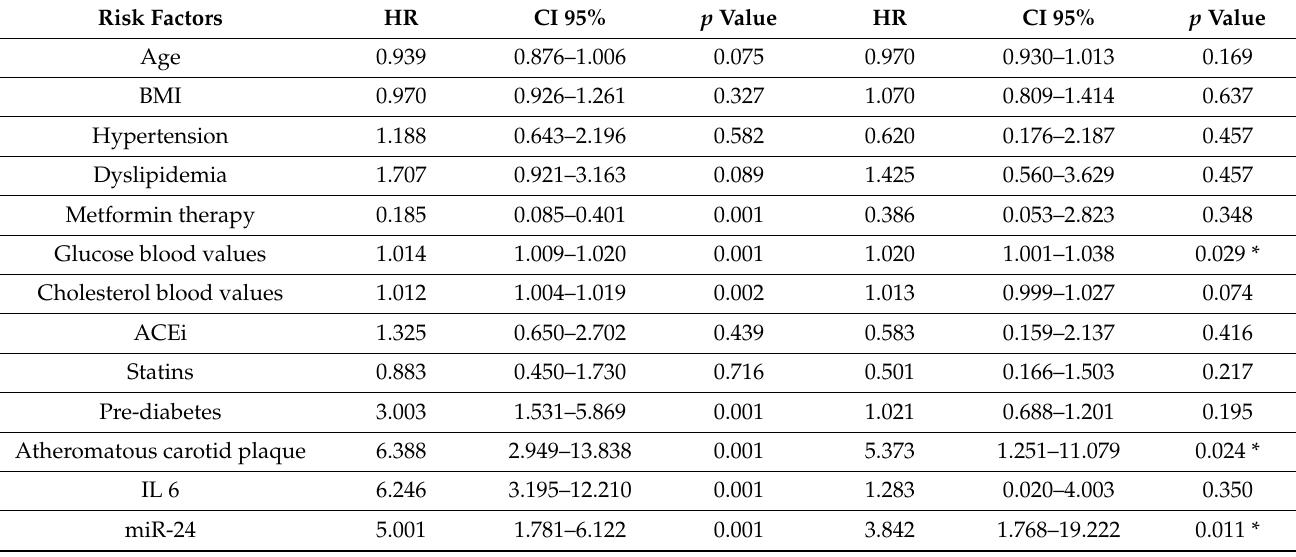
Table 3. Multivariate Cox Regression analysis to predict major adverse cardiac events (MACE) at 2 years of follow-up. Risk